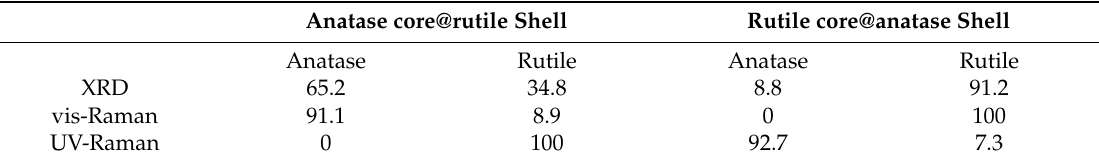
Table 2. Crystallographic composition (%) of anatase core@rutile shell TiO 2 nanofibers and rutile